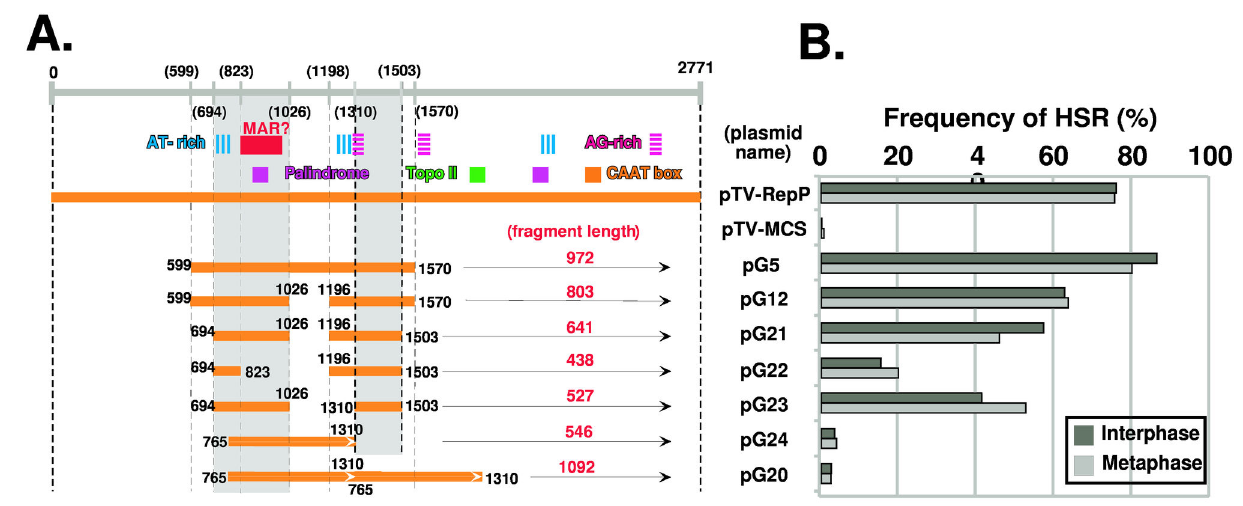
Figure 6. Dissection of the ß-globin replicator using a plasmid stability assay. (4) . The regions indicated by orange bars in panel A were subjected to the plasmid-stability assay in COLO 320DM cells, as in Figure 2. pG20 contains a direct repeat of fragment G24 (765-1310). The results from both cell lines are shown in panel B. The data suggest that the gray rectangular regions drawn in the left panel have HSR-generation